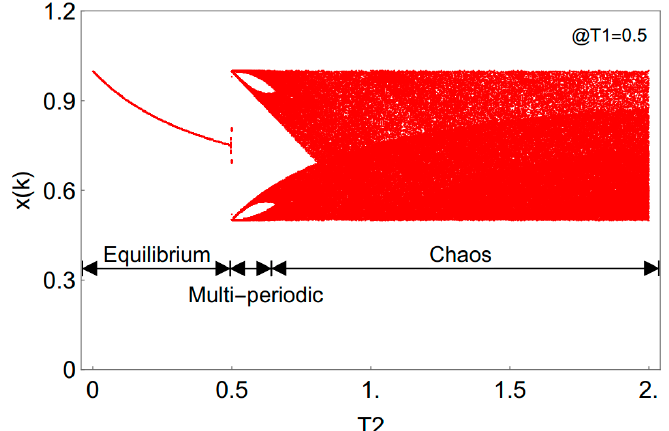
Figure 5. Bifurcation diagram versus T 2 of the mathematical model of the proposed N-shaped chaos generator. The range of T 2 associated with the dense area of the diagram shows chaotic behavior and can be used later to design Complementary Metal Oxide Semiconductor (CMOS) chaotic circuit.